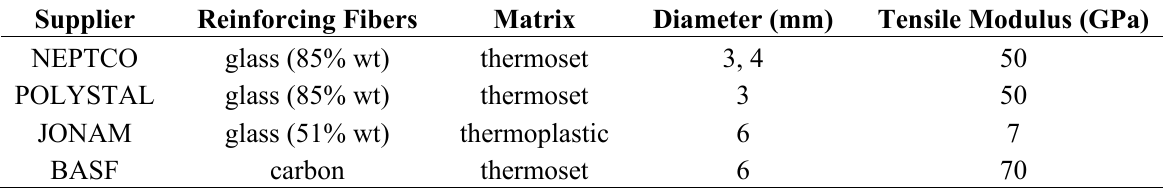
Table 2. Physical and mechanical properties of pultruded